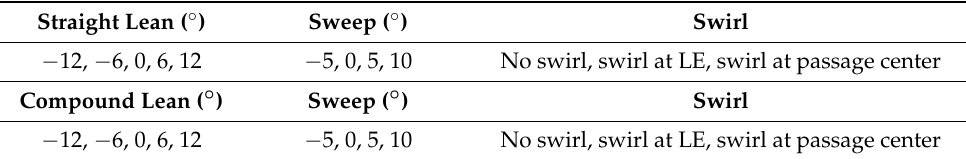
Figure 7. Swirl vector at inlet plane: ( a ) Swirl at LE; ( b ) Swirl at passage center. Table 3. 3D NGV geometry combination matrix.